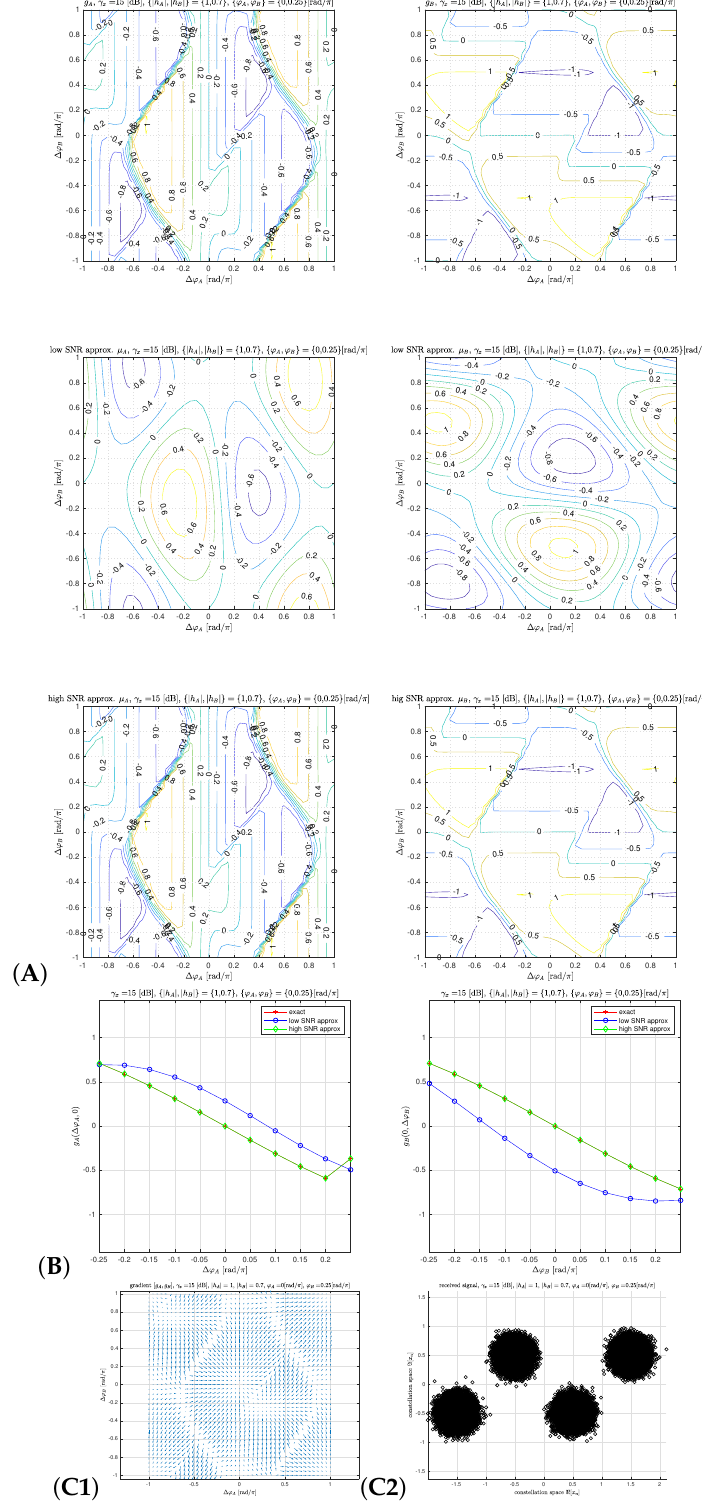
Figure 4. Equivalent detector characteristics for γ x = 15 dB, h A = 1e j0 , h B = 0.7e j0.25 π . ( A ) detector components g A ( ∆ ϕ ) , g B ( ∆ ϕ ) (row #1) exact , (row #2) low SNR approximation, (row #3) high SNR approximation; ( B ) detector components g A ( ∆ ϕ A ,0 ) , g B ( 0, ∆ ϕ B ) ; ( C1 ) gradient directions (exact); ( C2 ) random received constellation